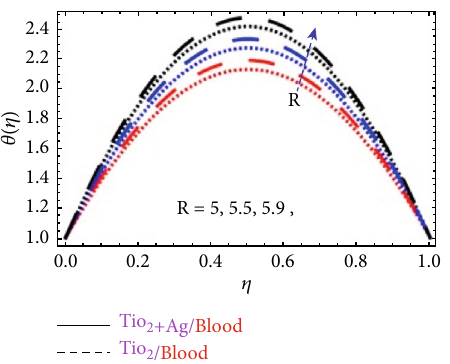
Figure 5: Inspiration of Prandtl number on Pr temperature pro fi le.